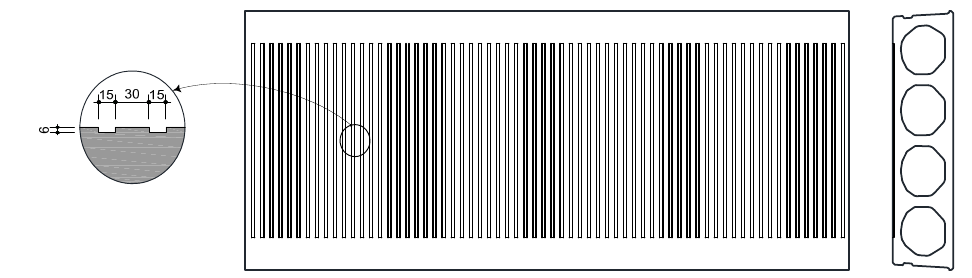
Figure 5. Upper surface of CS series (unit: mm).